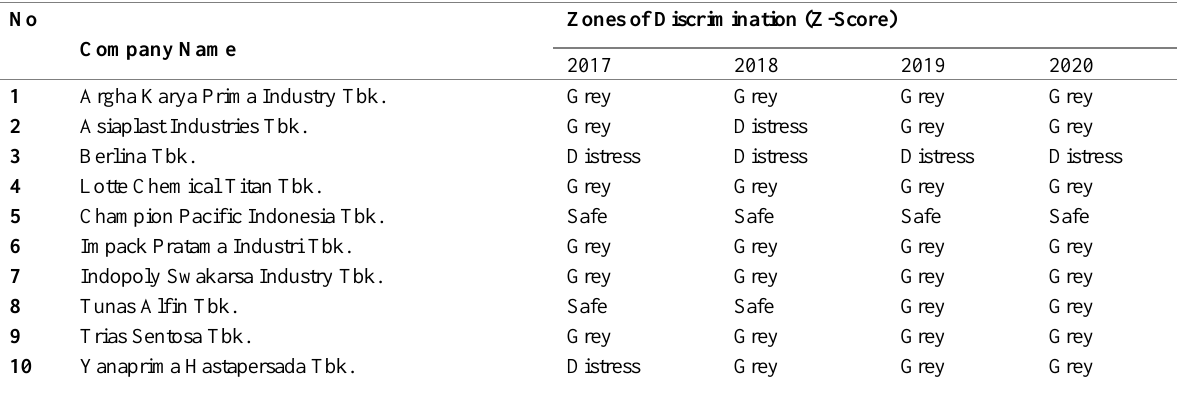
Table 7: Company Conditions During